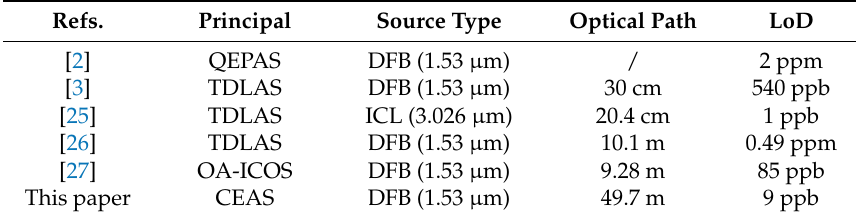
Table 2. Comparison between this system and other reported C 2 H 2 detection systems. LoD, limit of detection; ICL, interband cascade